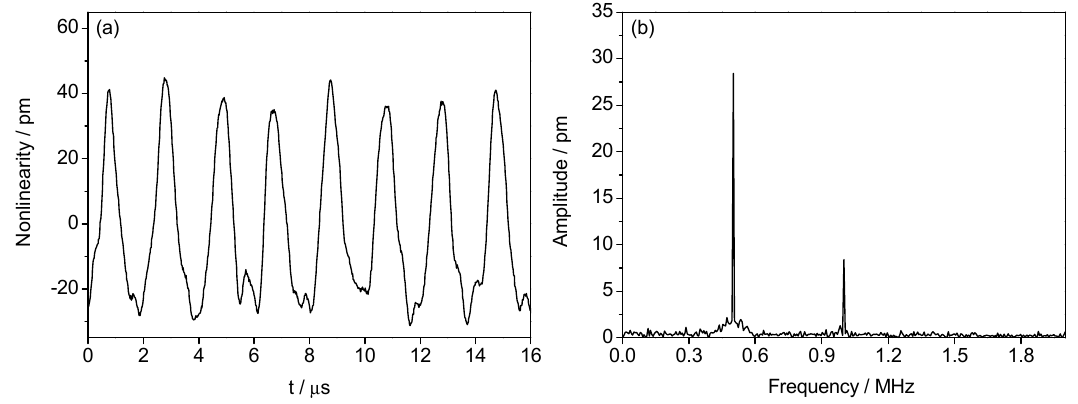
Figure 4. Experimental results of nonlinearities in condition of uniform motion with ∆ f = 5 MHz, f = 0.5 MHz, A : α 1 : α 2 = B : β : β = 10 , 000:6:2. ( a ) Time domain and; ( b ) frequency domain.